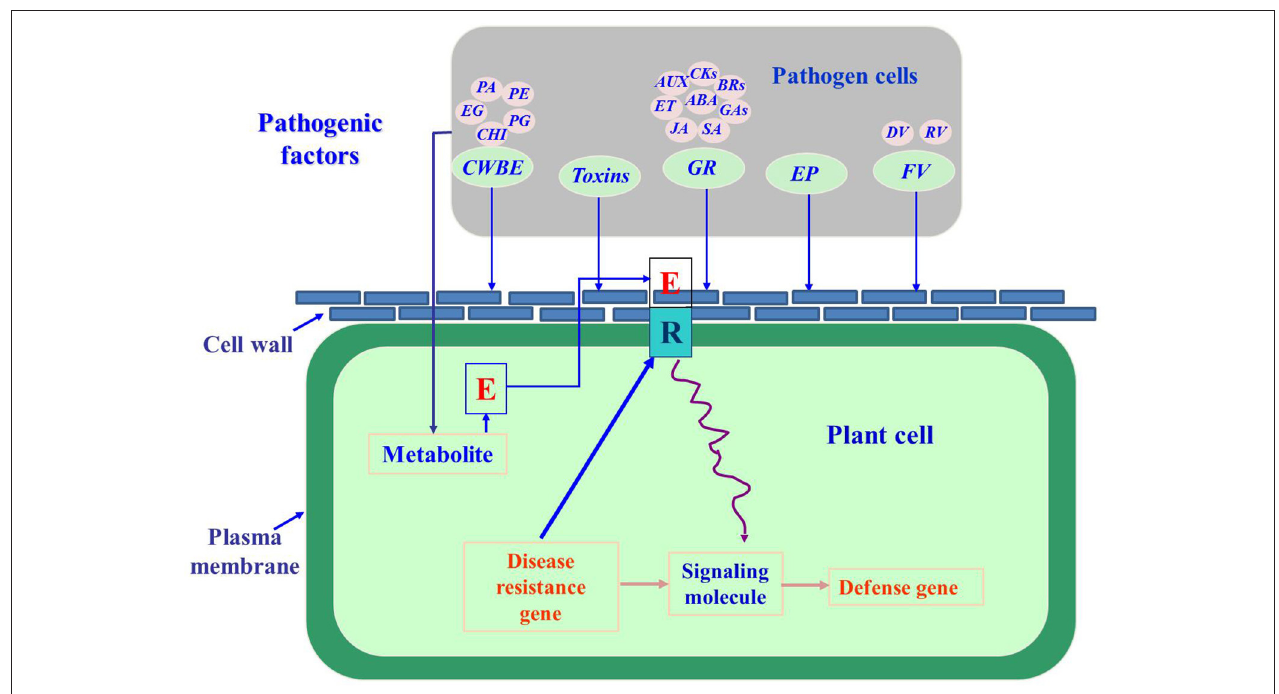
FIGURE 1 | The pathogenic factors of phytopathogenic fungi (Lara-Márquez et al., 2011; Zhang et al., 2014; Gomes et al., 2015; Guerriero et al., 2015; Li et al., 2017; Tan and Oliver, 2017; Proctor et al., 2018; Abro et al., 2019; Azhar et al., 2019; Cobos et al., 2019 ). CWBE, cell wall-degrading enzymes; PG, pectin polygalacturonase; PE, pectin methylesterase; EG, Endo-1,4- β -D-glucanase; PA, protease; CHI, chitinase; GR, growth regulator; AUX, auxin; CKs, cytokinins; BRs, brassinolides; ABA, abscisic acid; GA, gibberellic acid; SA, salicylic acid; JA, jasmonic acid; ET, ethylene; EP, effector proteins; FV, fungal virus; DV, DNA virus; RV, RNA